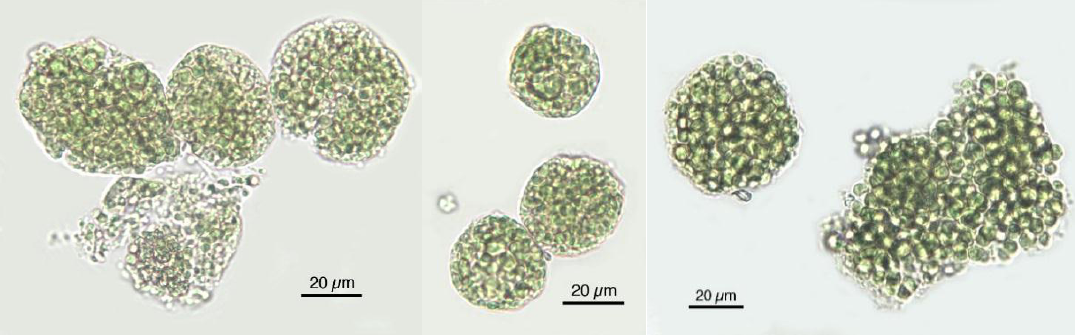
Figure 5. The microscopic unicellular Chlorella cells tend to agglomerate also in food supplements. Its properties and capacities have been idealized and emphasized in various